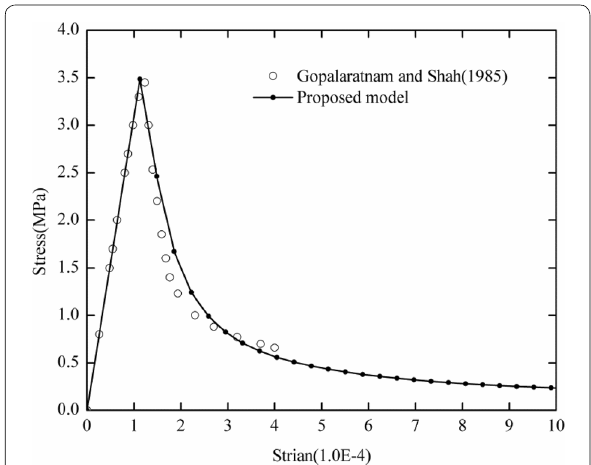
Fig. 9 The model responses in monotonic uniaxial tension compared to experimental results presented in Gopalaratnam and Shah (1985).